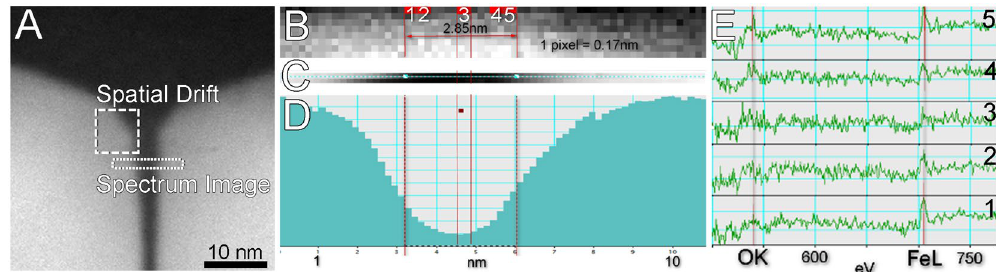
Figure 7. EELS of adjacent Fe 3 O 4 magnetosomes in a cell of an uncultured freshwater coccoid MTB from a pond in Strasbourg France. ( A ) STEM HAADF image of two contiguous Fe 3 O 4 magnetosomes in a chain. Spectrum image acquisition region and spatial drift (dwell time 2 s, camera length 2 cm, pixel size 0.17 nm). ( B ) Spectrum image obtained in the region highlighted in ( A ). Each acquired pixel can be assigned to an individual spectrum shown in figure ( E ). To enhance the signal to noise ratio, the signal from two pixels was added to give spectra in ( E ). ( C ) HAADF image or morphological map of the first line of STEM image acquired simultaneously as the spectrum image. ( D ) Morphological profile of the region between two magnetosomes. ( F ) EELS signals obtained from positions 1, 2, 3, 4, and 5 in spectrum image show in ( B ). Fe signals were found in all